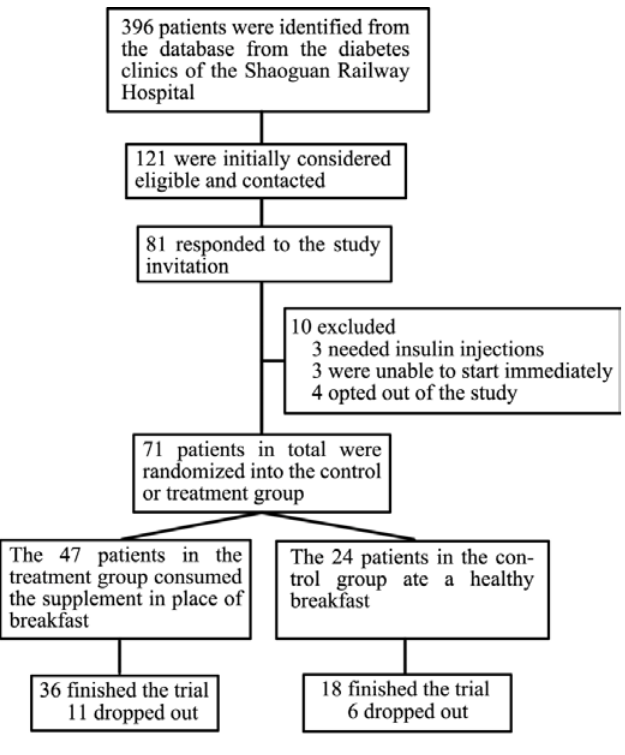
Figure 1. Flow diagram of